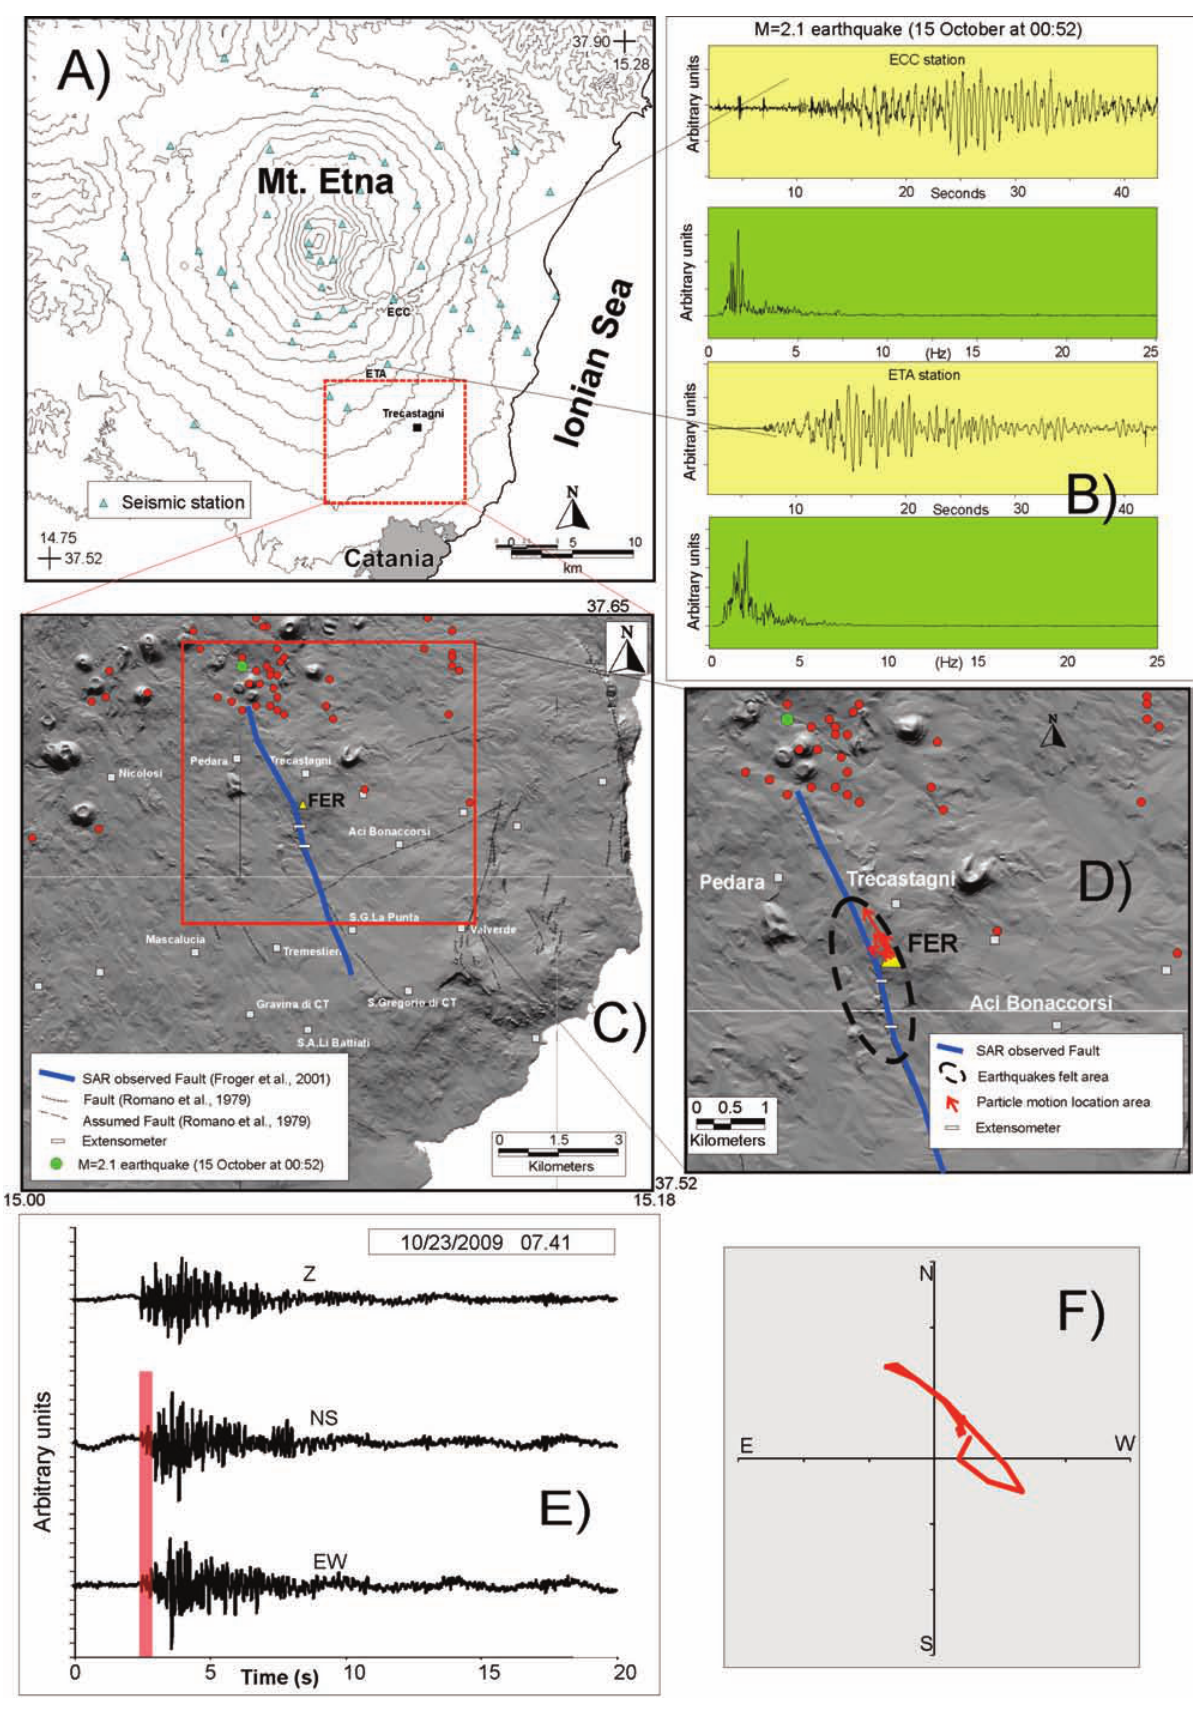
Figure 6. The Istituto Nazionale di Geofisica e Vulcanologia, Sezione di Catania, permanent seismic network (A; triangles), waveforms and spectra related to the October 15, 2009, 00:52 event recorded at the ECC (top panels) and ETA (lower panels) stations (B), seismicity recorded in the TF area between May 2005 and April 2010 (C, D), with microearthquake epicenters recorded at the FER station obtained from particle motion analysis and S-P seismic phase time lapse (D). Examples of waveform recorded at FER station (E); the red bar indicate the time window used for particle motion